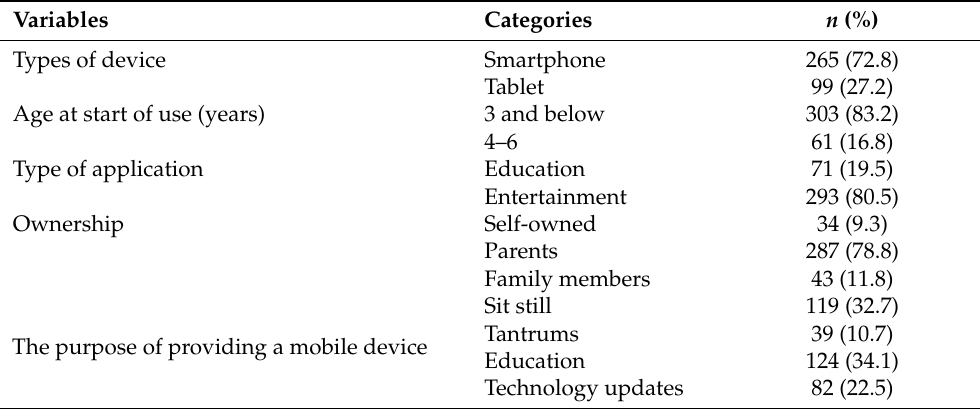
Table 2. Mobile device usage